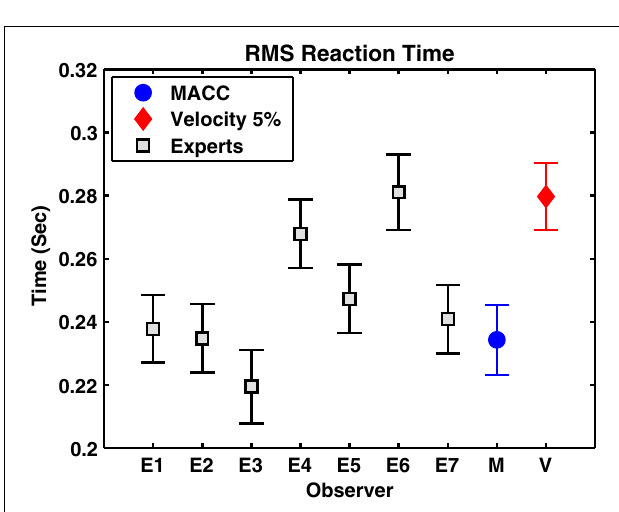
FIGURE 5 | The RMS onset time of seven experts (E1 through E7) on a real database compared to MACC and 5% threshold techniques. Gray: individual mean expert performance; Blue: MACC mean onset detection; Red: 5% velocity threshold onset detection. Graph shows that the experts’ variabilities range between those of the MACC and of the velocity threshold techniques. Onset detection of fi ve out of the seven experts does not differ statistically from the MACC. The onset detection trend present in the synthetic database between the three methods also exists in this